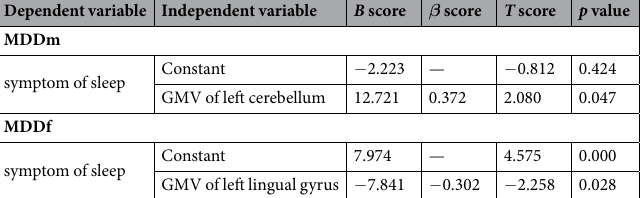
Table 3. Predictors of sleep disturbance in patients with MDD. MDD: Major Depressive Disorder; MDDm: male patients with major depressive disorder; MDDf: female patients with major depressive disorder. GMV: gray matter